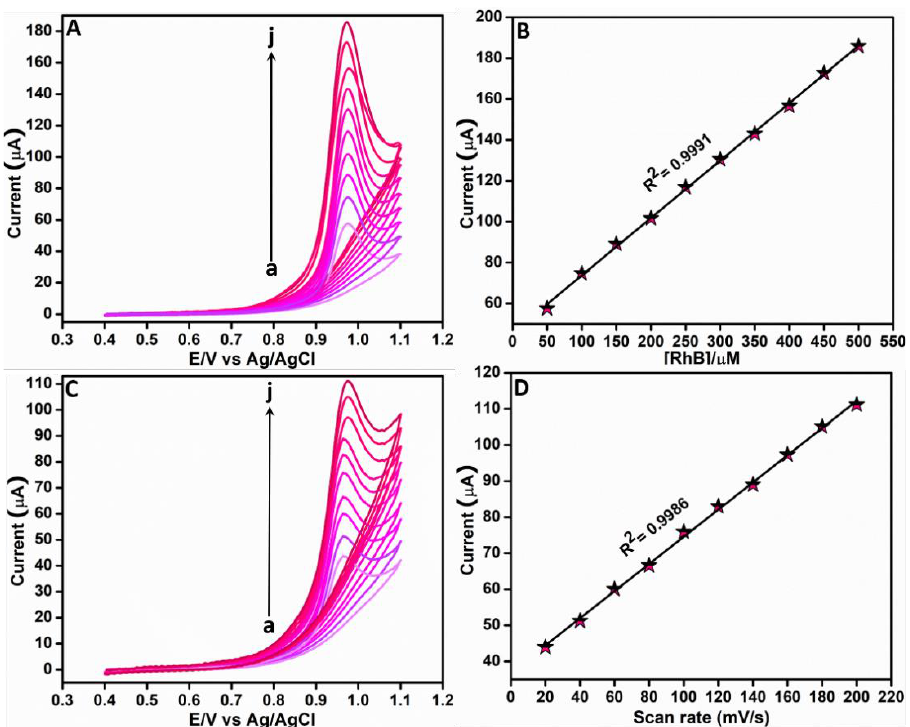
Figure 6. ( A ) Voltammetric curves of Ag-3/ZnO/SPCE under different additions of RhB from 50 µ M to 500 µ M to 0.05 M PBS (pH 7) at 0.1 V/s and ( B ) Corresponding linear plot. ( C ) Voltammetric curves of Ag-3/ZnO/SPCE under different scan rates from 0.02–0.2 V/s and ( D ) corresponding linear plot.